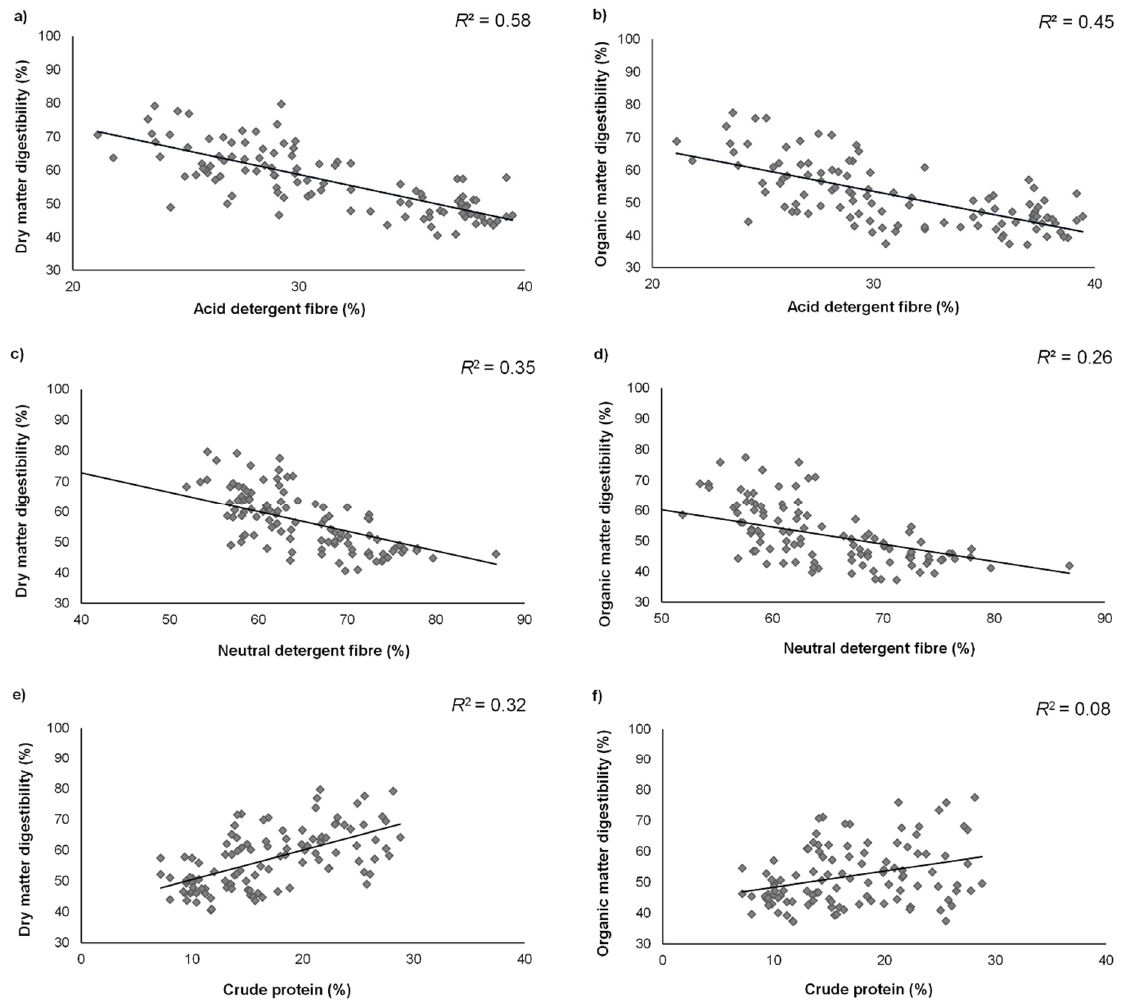
Figure 4. Regression analysis of the dry matter digestibility and ( a ) acid detergent fibre, ( c ) neutral detergent fibre and ( e ) crude protein and plots of organic matter digestibility and ( b ) acid detergent fibre, ( d ) neutral detergent fibre and ( f ) crude protein. Values of r 2 values are also presented.